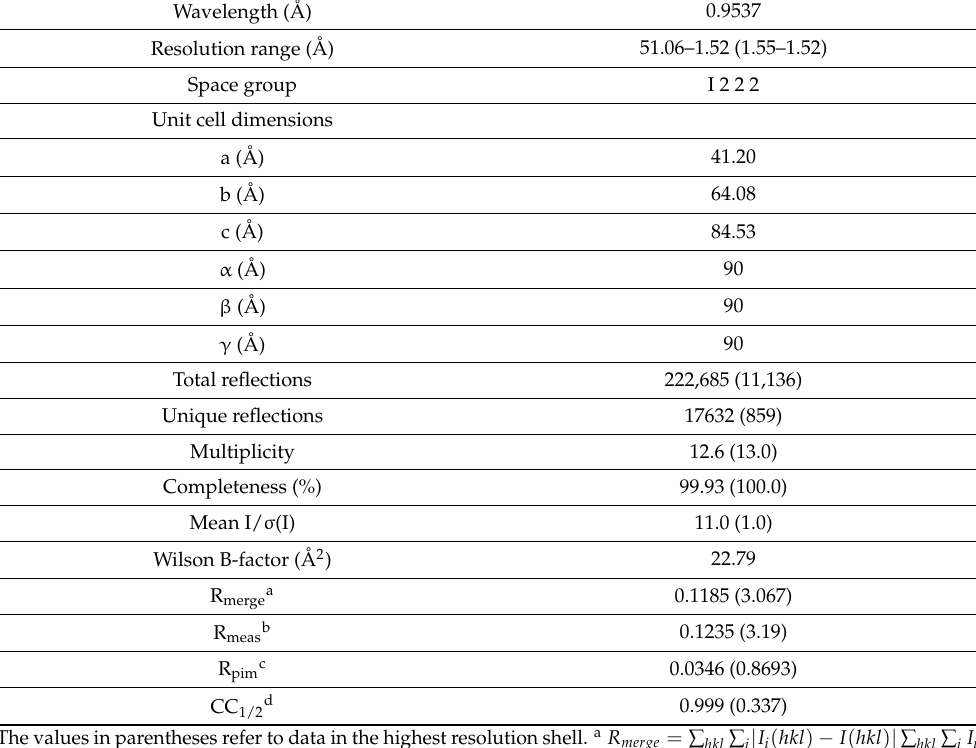
Table 2. Data collection statistics for the hTTR-VCP-6